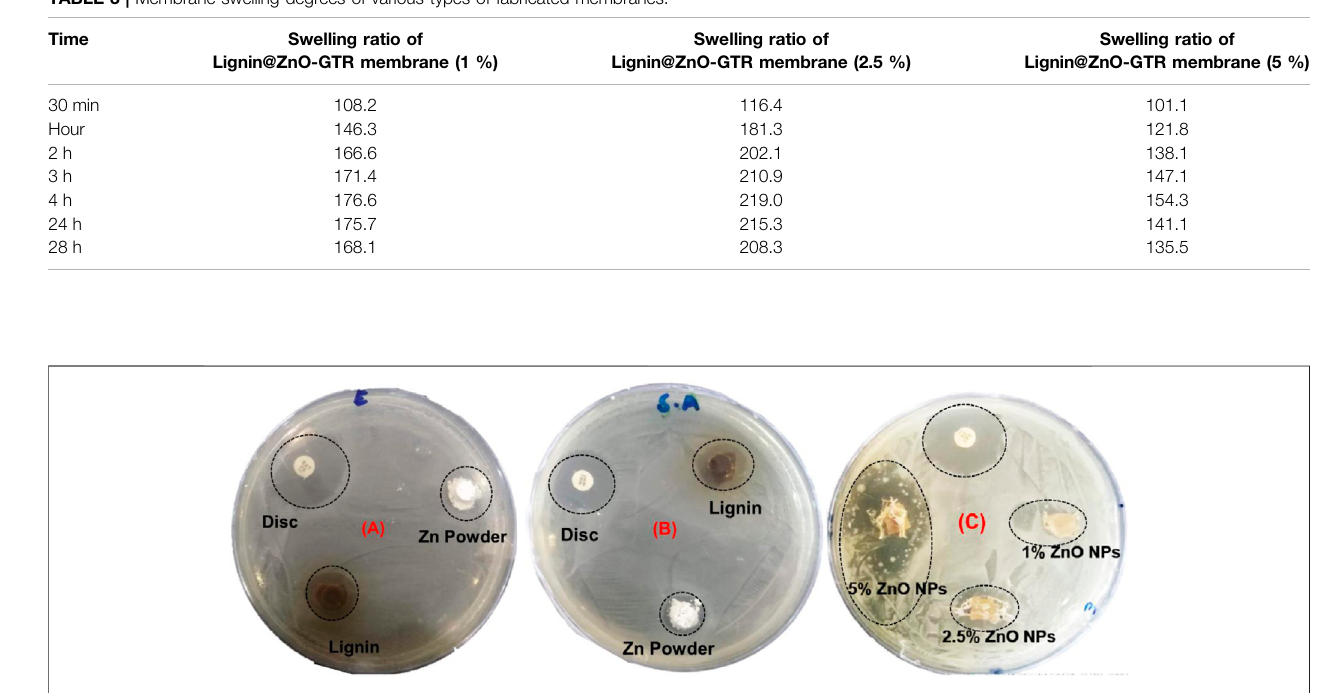
FIGURE 7 | Zone of inhibition of synthesized Lignin@ZnO and commercial zinc oxide powder for (A) E . coli , (B) S . aureus , and (C) zone of inhibition of GTR membrane against E . coli .